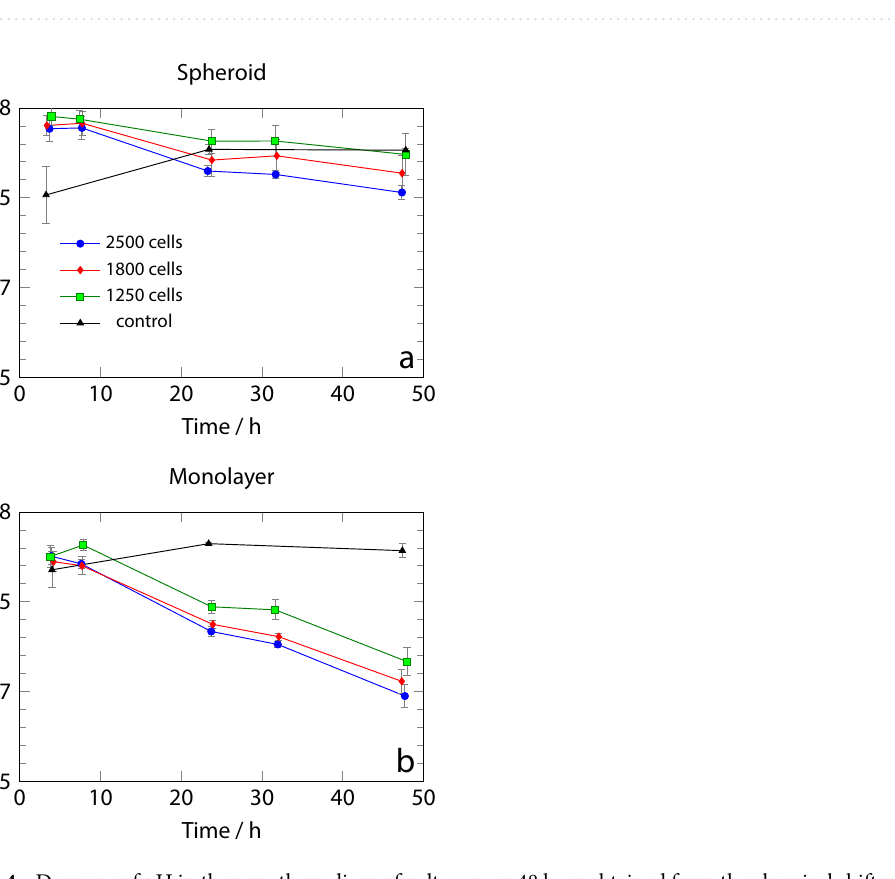
Figure 4. Decrease of pH in the growth medium of culture over 48 h, as obtained from the chemical shift of the HEPES peak near 3.8 ppm (a) spheroids; (b) monolayer culture. Solid lines are guides to the